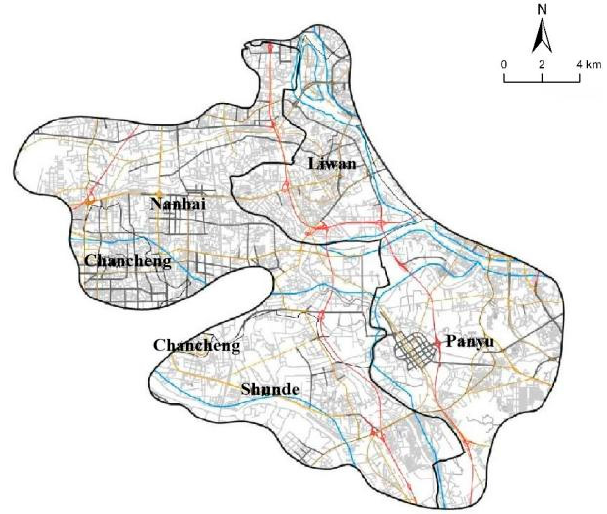
Figure 4. Delineating key border area of Guangzhou-Foshan development.